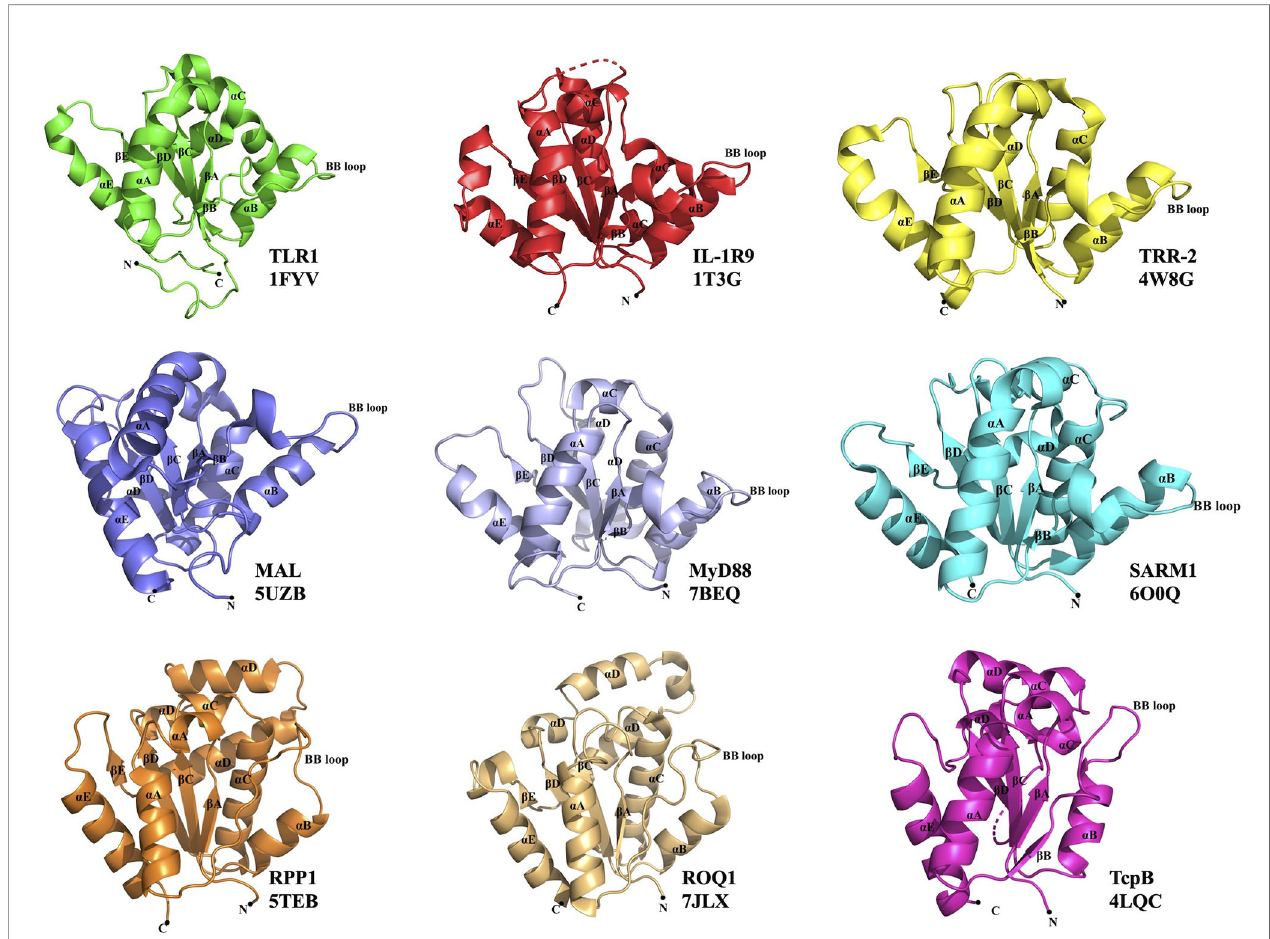
FIGURE 1 | Representative TIR domain structures. TIR domains of the human (TLR1, IL-1R9, MAL, MyD88 and SARM1), lower metazoan Hydra magnipapillata (TRR-2), plant (RPP1 and ROQ1) and bacterial (TcpB) proteins with their corresponding PDB IDs are shown. All the TIR domains show a central core of fi ve b - strands ( b A – b E) surrounded by fi ve a -helices ( a A – a E). The functionally important BB-loop in each TIR is